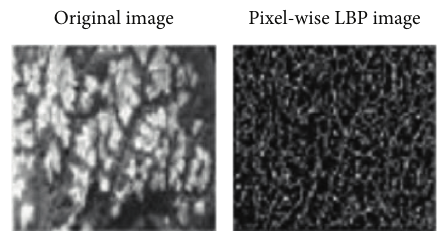
Figure 7: Grey image with LBP pixel-wise